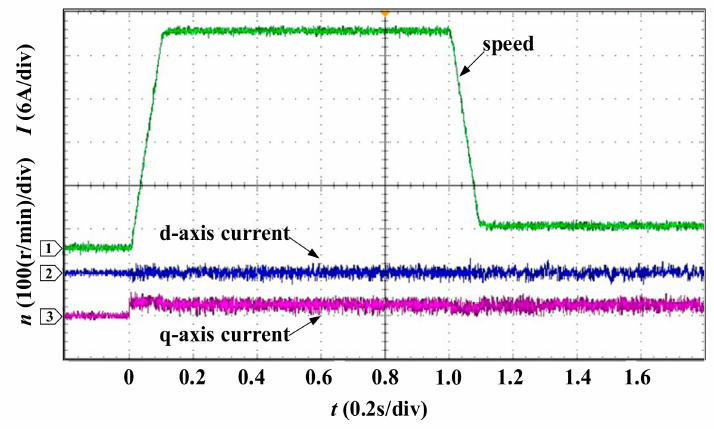
Figure 6. Experimental results of motor speed variation under second-order sliding mode control strategy.